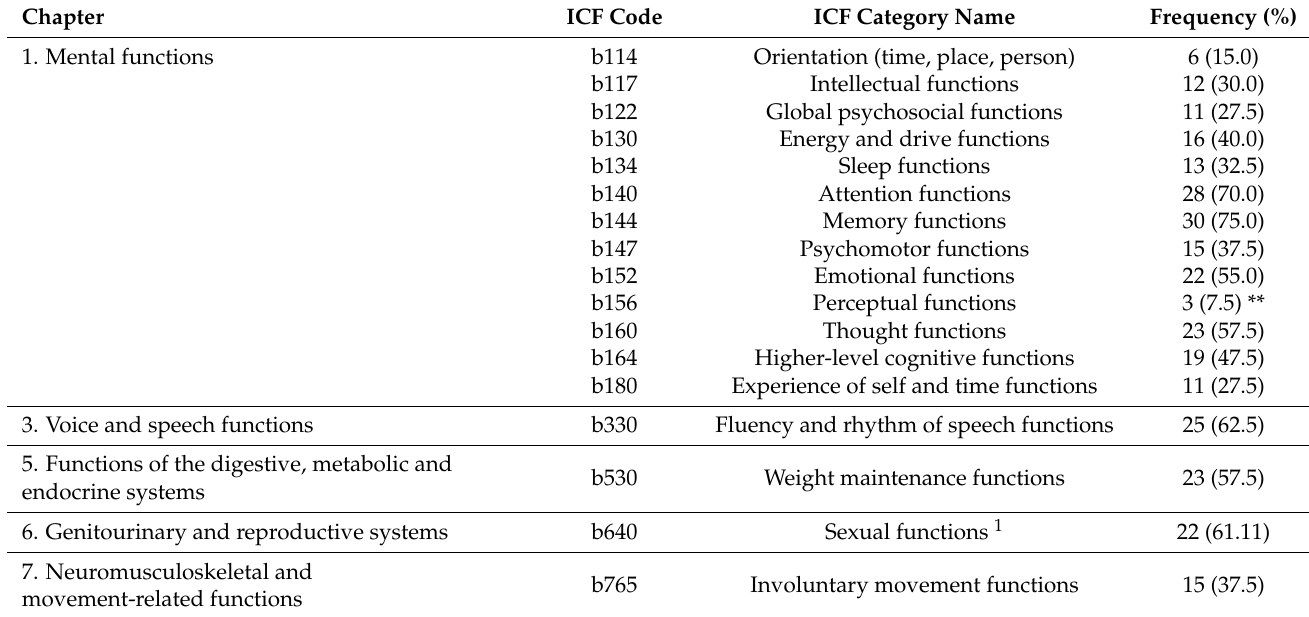
Table 2. Frequency and percentage of participants with impairments * on the ICF categories of the Body functions component.